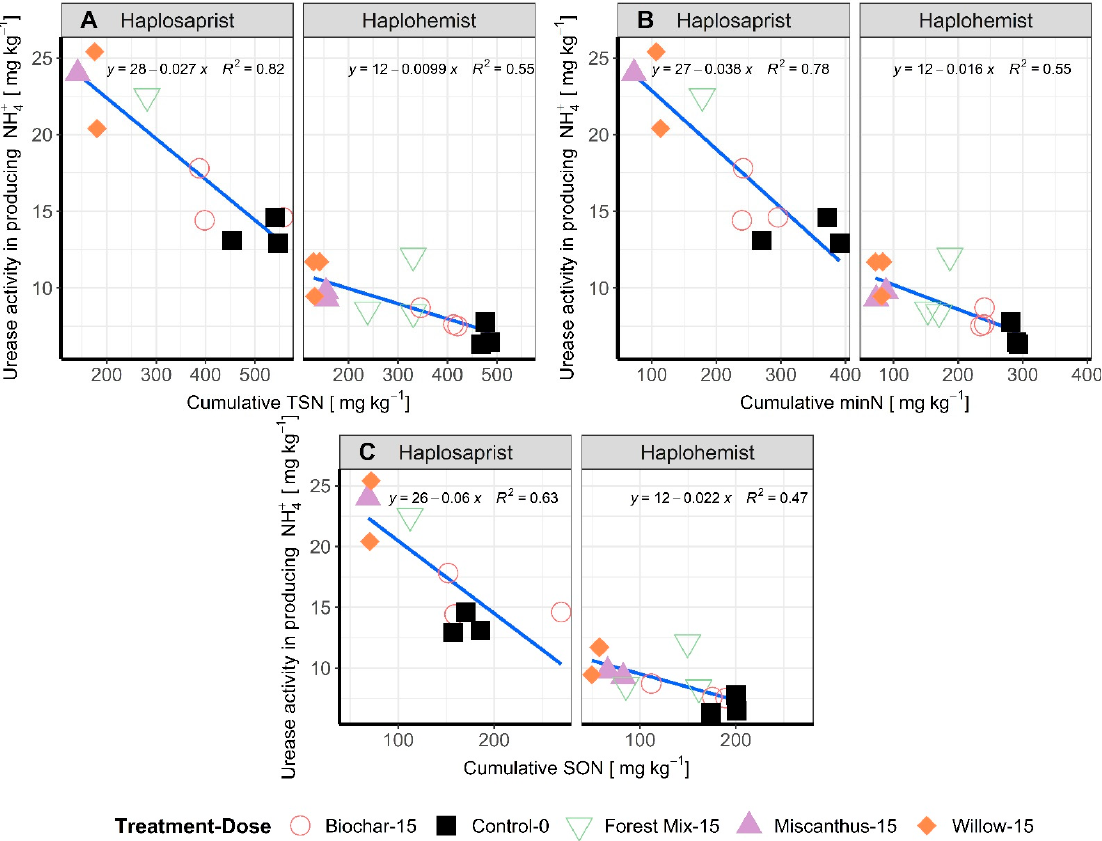
Figure 5. Cumulative measured TSN ( A ), minN ( B ), and SON ( C ) after 26 weeks of incubation, in relation to urease activity at the end of the incubation period for the two soil types. Amendments are represented by different colors and forms. The linear relationship is drawn, and the equation is presented at the top of the graph.